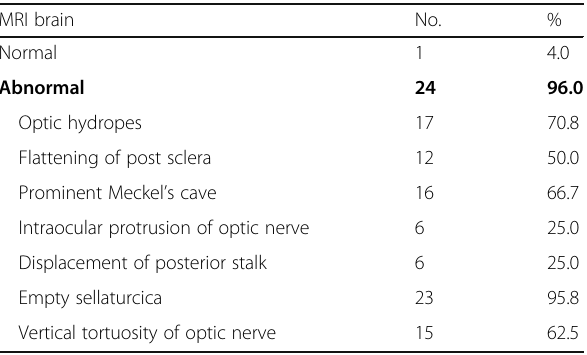
Table 2 Distribution of the studied cases according to MRI brain ( n = 25) MRI